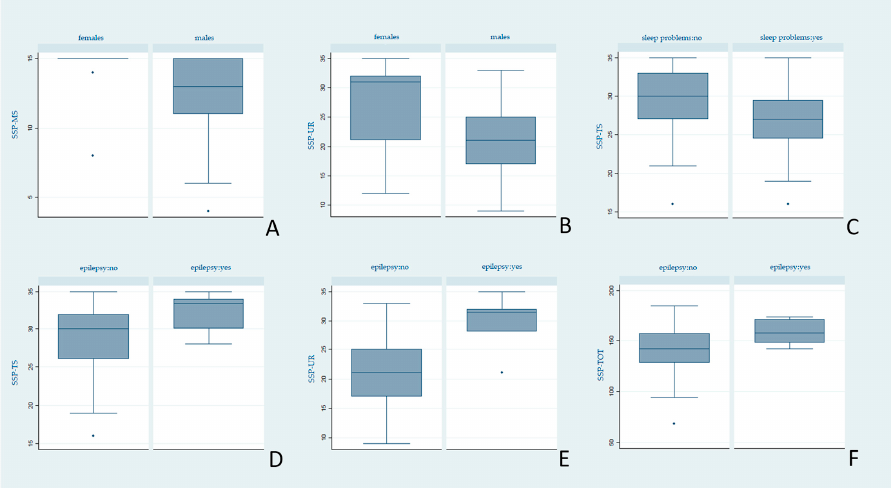
Figure 2. Differences in SSP median scores by clinical variables. Legend: Higher scores indicate less anomalies. ( A , B ) Males showed higher symptoms in Movement Sensitivity (SSP-MS) and Under-Responsive/Seeks Sensations (SSP-UR) compared with females, ( p = 0.01, p = 0.03 respectively). ( C ) Subjects with sleep problems presented higher anomalies in Tactile Sensitivity (SSP-TS) than subjects without sleep problems ( p = 0.04). ( D – F ) Subjects with epilepsy displayed less anomalies in Tactile Sensitivity (SSP-TS) ( p = 0.02), Under-Responsive/Seeks Sensations (SSP-UR) ( p = 0.008) and SSP total score (SSP-TOT) ( p = 0.04) than subjects without epilepsy.